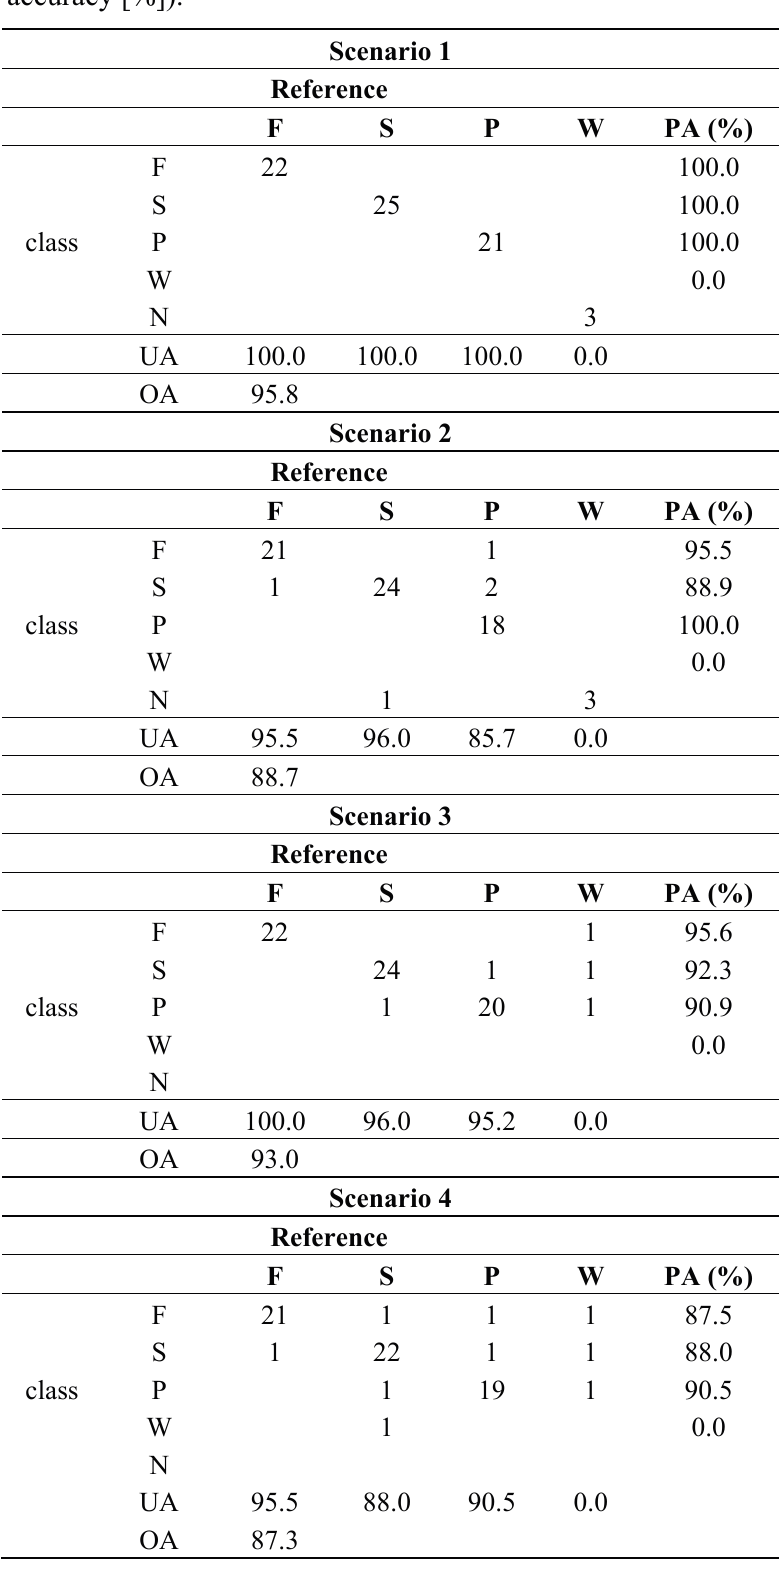
Table 4. Accuracy of each scenario by class (F = forest, S = scrub, P = prairie, N = Not classified, PA = producer’s accuracy [%], UA = user’s accuracy [%], OA = overall accuracy